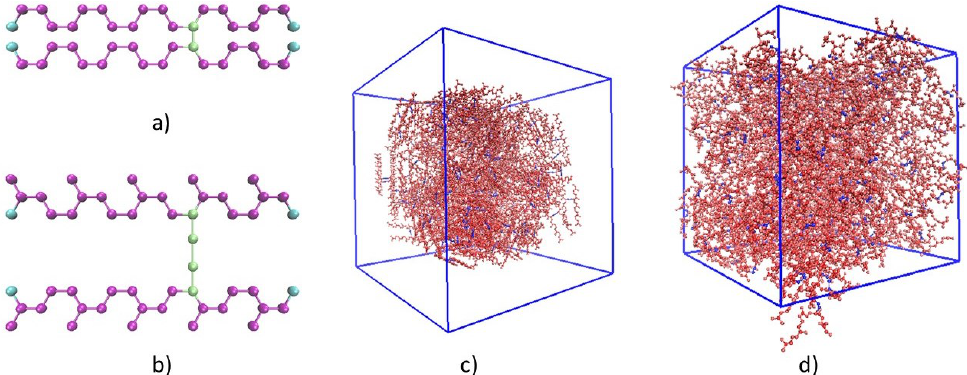
Figure 1. ( a ) Input structure of a molecule for the MD simulation of polybutadiene crosslinked by C-C bridges with a degree of crosslinking of 20%; ( b ) input structure of a molecule for MD simulation of polyisoprene crosslinked by C-S-S-C bridges with a degree of crosslinking of 20%; ( c ) input molecules distributed randomly in the periodic supercell for modeling of polyisoprene vulcanized by sulfur with a degree of crosslinking of 20%; ( d ) structure of polyisoprene vulcanized by sulfur with a degree of crosslinking of 20% before calculation of the thermal